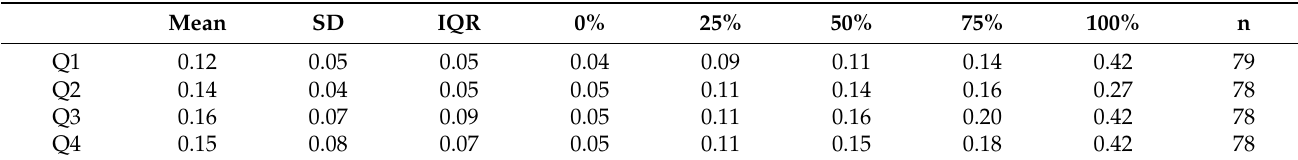
Table 11. Complaints of Gender Violence by a municipality. Sources: own elaboration based on data from the Galician Institute of Statistics (IGE), Municipal Register of Inhabitants, the year 2021, General Council of the Judiciary (CGPJ).